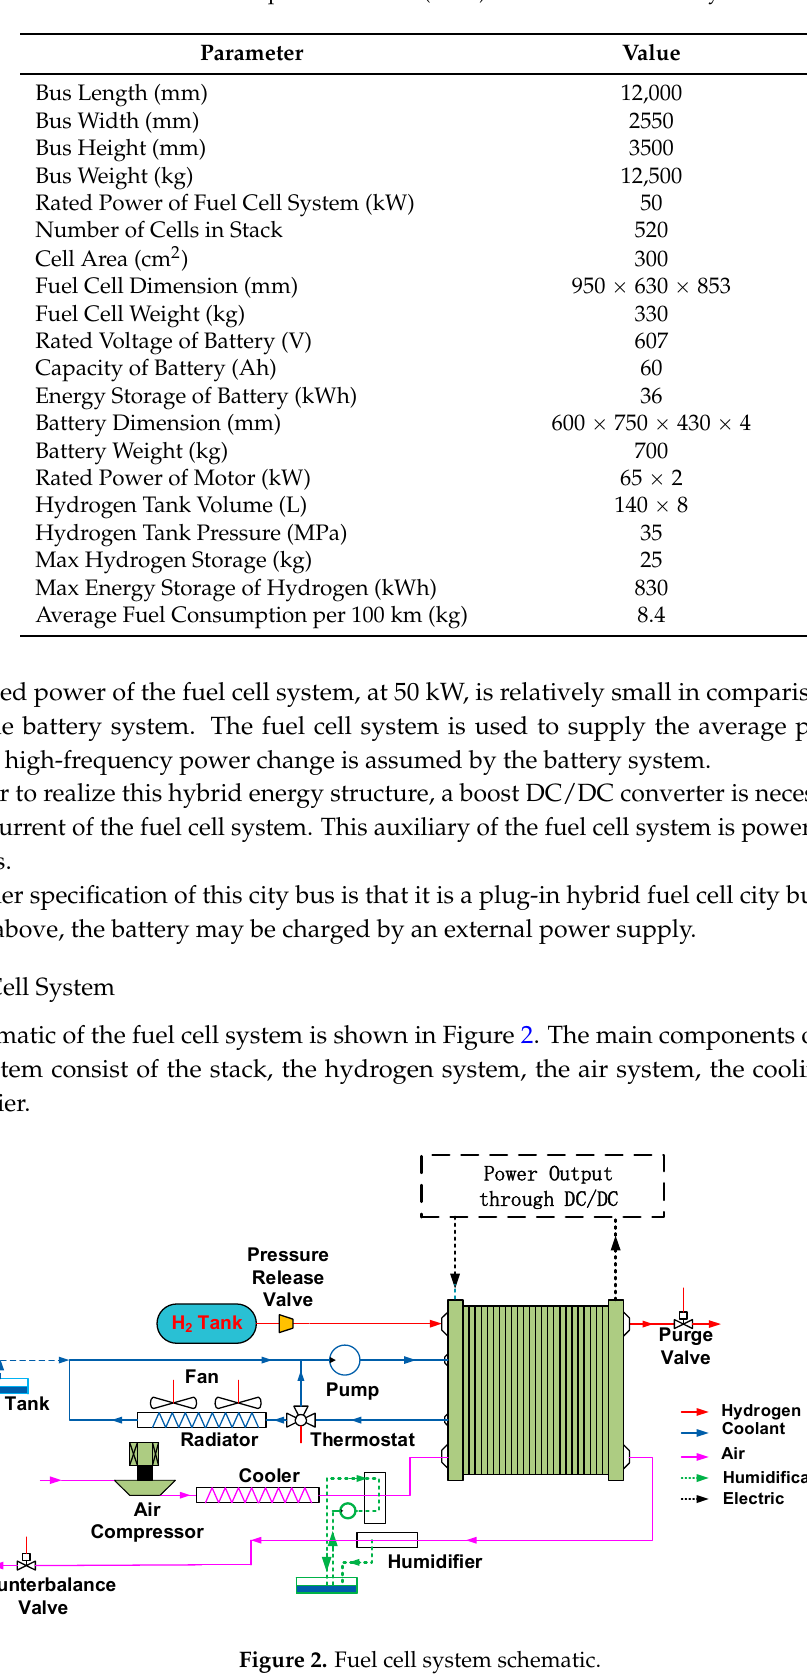
Table 1. Main specifications of (PEM) FCEV bus in this study.